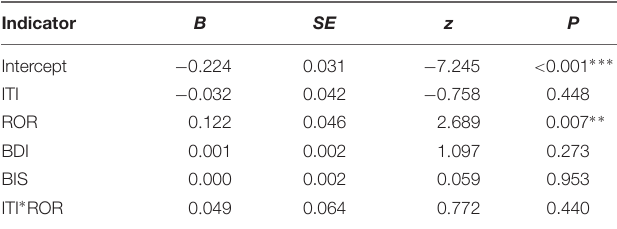
TABLE 1 | Offset negative binomial regression model of acquisition data.